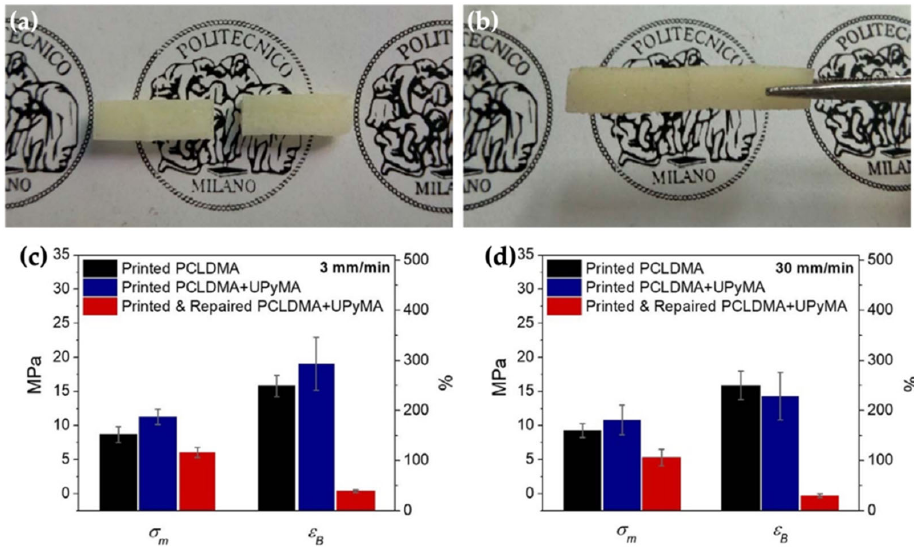
Figure 7. Self ‐ healing results of PCLDMA–UPyMA samples. Images of the cut samples ( a ) and completely repaired samples after the healing process at 80 °C ( b ). Tensile strength ( σ m ) and elongation at break ( ε B ) of PCLDMA samples (black), PCLDMA–UPyMA samples (blue), and self ‐ healing samples (red), resulted in test speeds of 3 mm/min ( c ) and 30 mm/min ( d ). Adapted from [52], Copyright 2018, with permission from Elsevier.